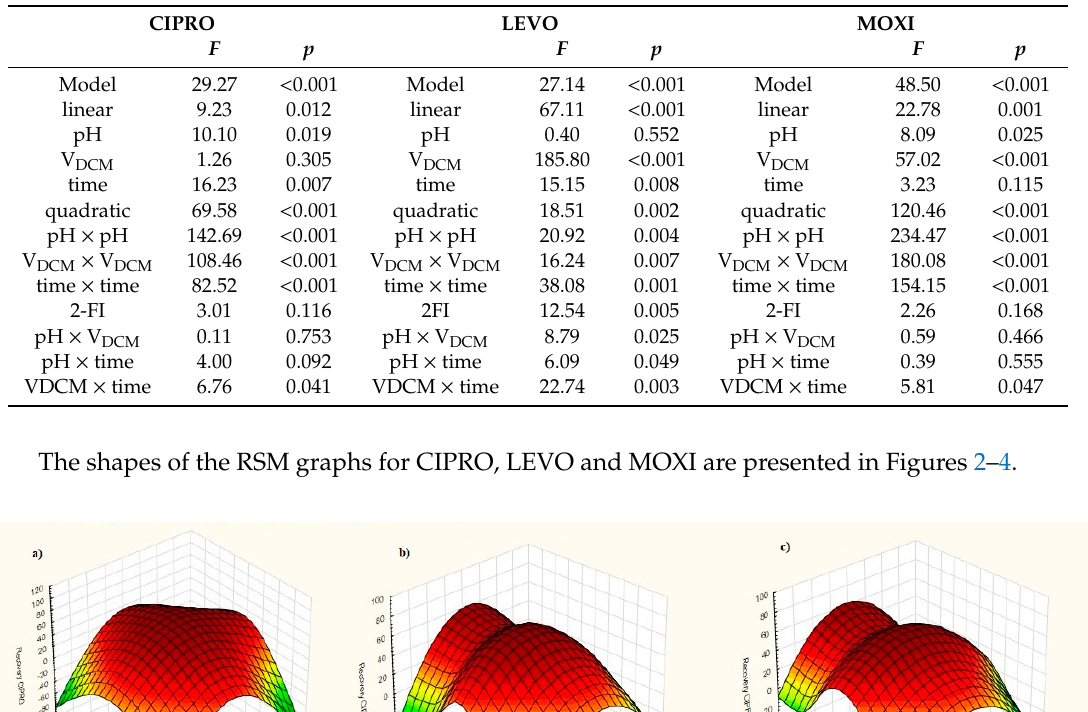
Table 6. The statistical analysis of CCD for the analytes.